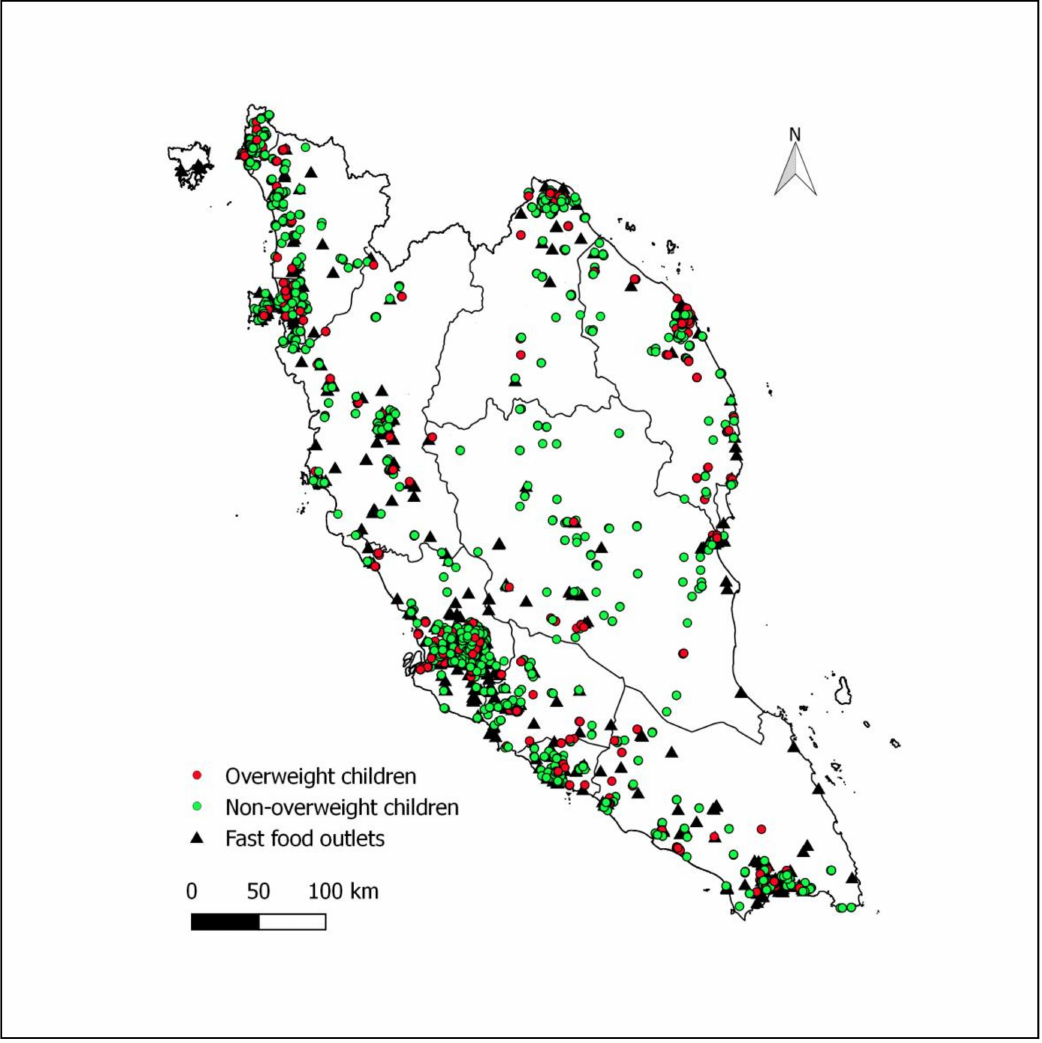
Figure 1. Distribution of fast-food outlets and houses of overweight (BMI-for-age z-score > +1 SD based on the WHO growth reference) and non-overweight children in Peninsular